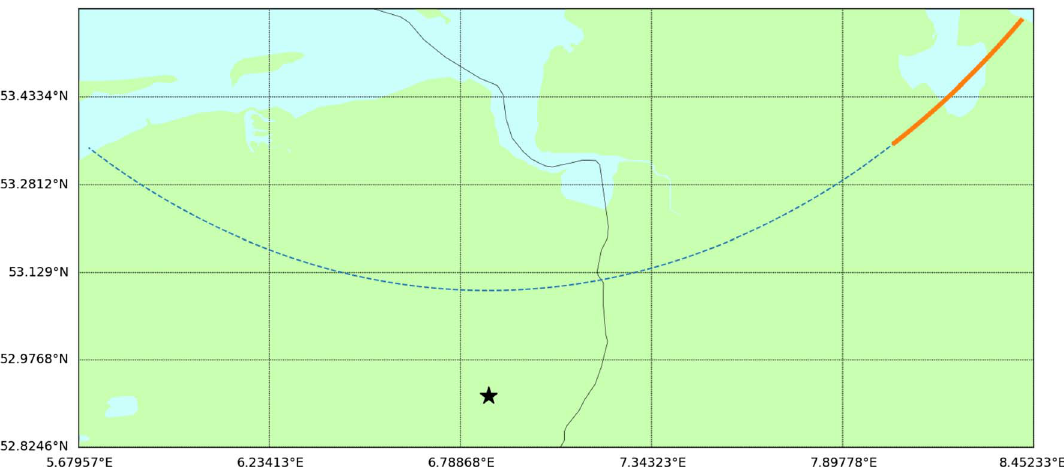
Fig. 6. Map showing the track of the 200 km pierce point of the line of sight from core station CS002 to Cassiopeia A from 2013-08- 18T21:05:00 UT to 2013-08-19T04:05:00 UT. The thicker orange part of the track enhances the fi rst hour of the observation. The black line winding a path across the centre of the image is the location of the border between the Netherlands and Germany. The location of CS002 is marked with a black star.